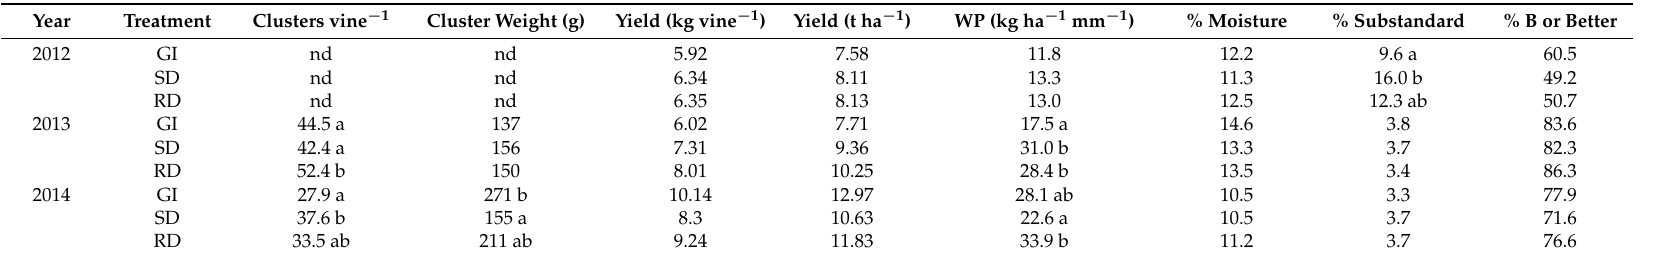
Table 4. Summary of the yield and quality components of the fiesta table grapes grown in Caruthers California. Water Productivity (WP) was calculated as kilogram of fruit/ha per mm of applied water for the grower irrigation (GI), sustained deficit (SD) and regulated deficit (RD) irrigation treatments. Moisture remaining in the fruit is given as % Moisture. Raisin grades include A, B and C and raisins graded C are considered Substandard and B or Better include both grades A and B (See Materials and Methods for Definition of